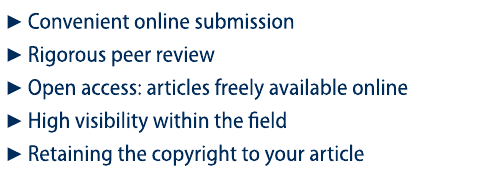
Tabbene O, Slimene IB, Djebali K, Mangoni ML, Urdaci MC, Limam F (2009) Optimization of medium composition for the production of antimicrobial activity by Bacillus subtilis B38. Biotechnol Prog 25(5):1267 – 1274 Zhang W, Ma L, Zhong F, Wang Y, Guo Y, Lu Y, Liang G (2015) Fitness costs